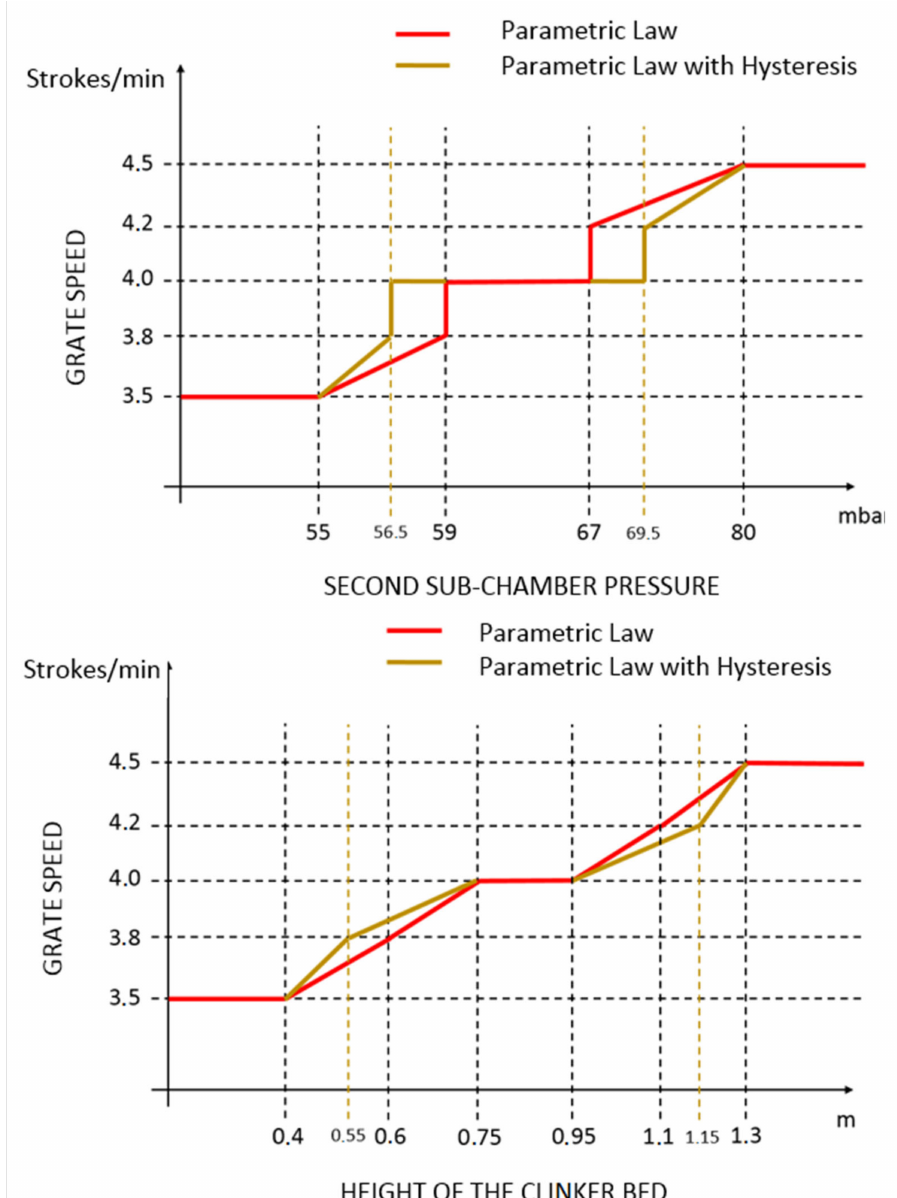
Figure 9. Grate cooler APC system: parametric law between second sub-chamber pressure/height of the clinker bed and grate